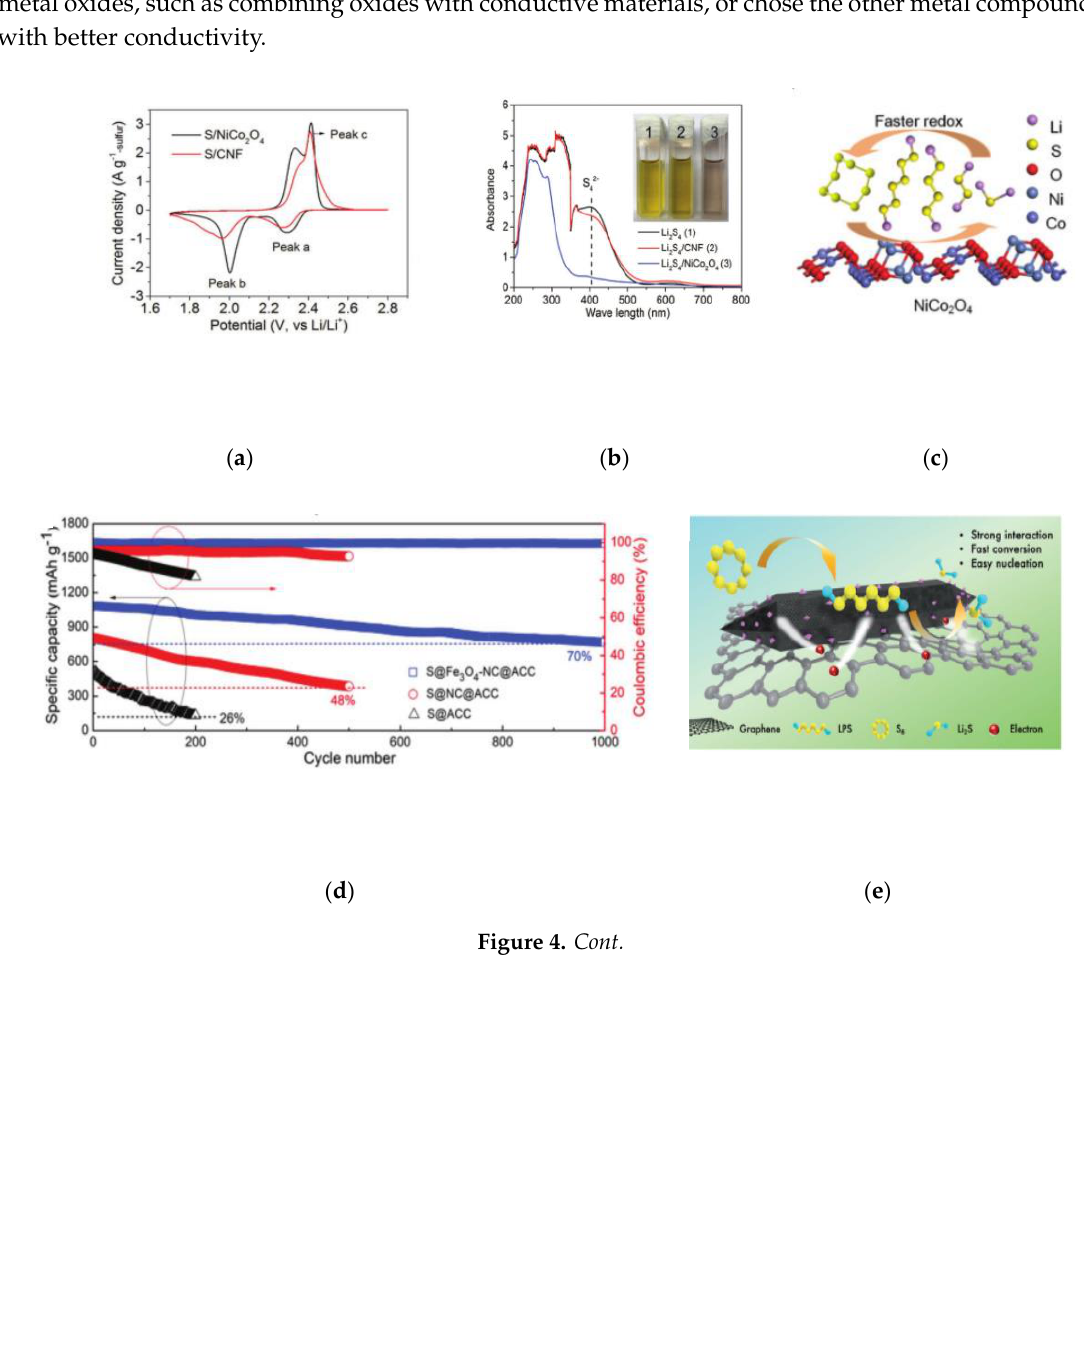
Figure 4. ( a ) CVs of the S/NiCo 2 O 4 and S/CNF composites at the scan rate of 0.1 mV s −1 [34] . ( b ) Demonstration of the static adsorption of Li 2 S 4 on NiCo 2 O 4 nanofibers and CNFs. UV–Vis spectra of supernatant of Li 2 S 4 solution after the adsorption test, and the corresponding photos (inset) [34] . ( c ) A schematic showing the faster redox kinetics of LiPS on the NiCo 2 O 4 surface [34] . ( d ) Cyclic stability and Coulombic efficiency (at 0.2 C) for sulfur impregnated in different composite cathodes as noted [35] . ( e ) Effective anchoring of polysulfides and promoting their conversion by Fe 3 O 4 /NC/G composites [36] . ( f ) Schematic illustration of the synthetic procedure of G-V 2 O 3 [37] . ( g ) EIS curves of S@G/G-V 2 O 3 and S@G/V 2 O 3 cathodes with a sulfur mass loading of 3.6 and 3.5 mg cm −2 , respectively [37] . 3.2. Sulfides